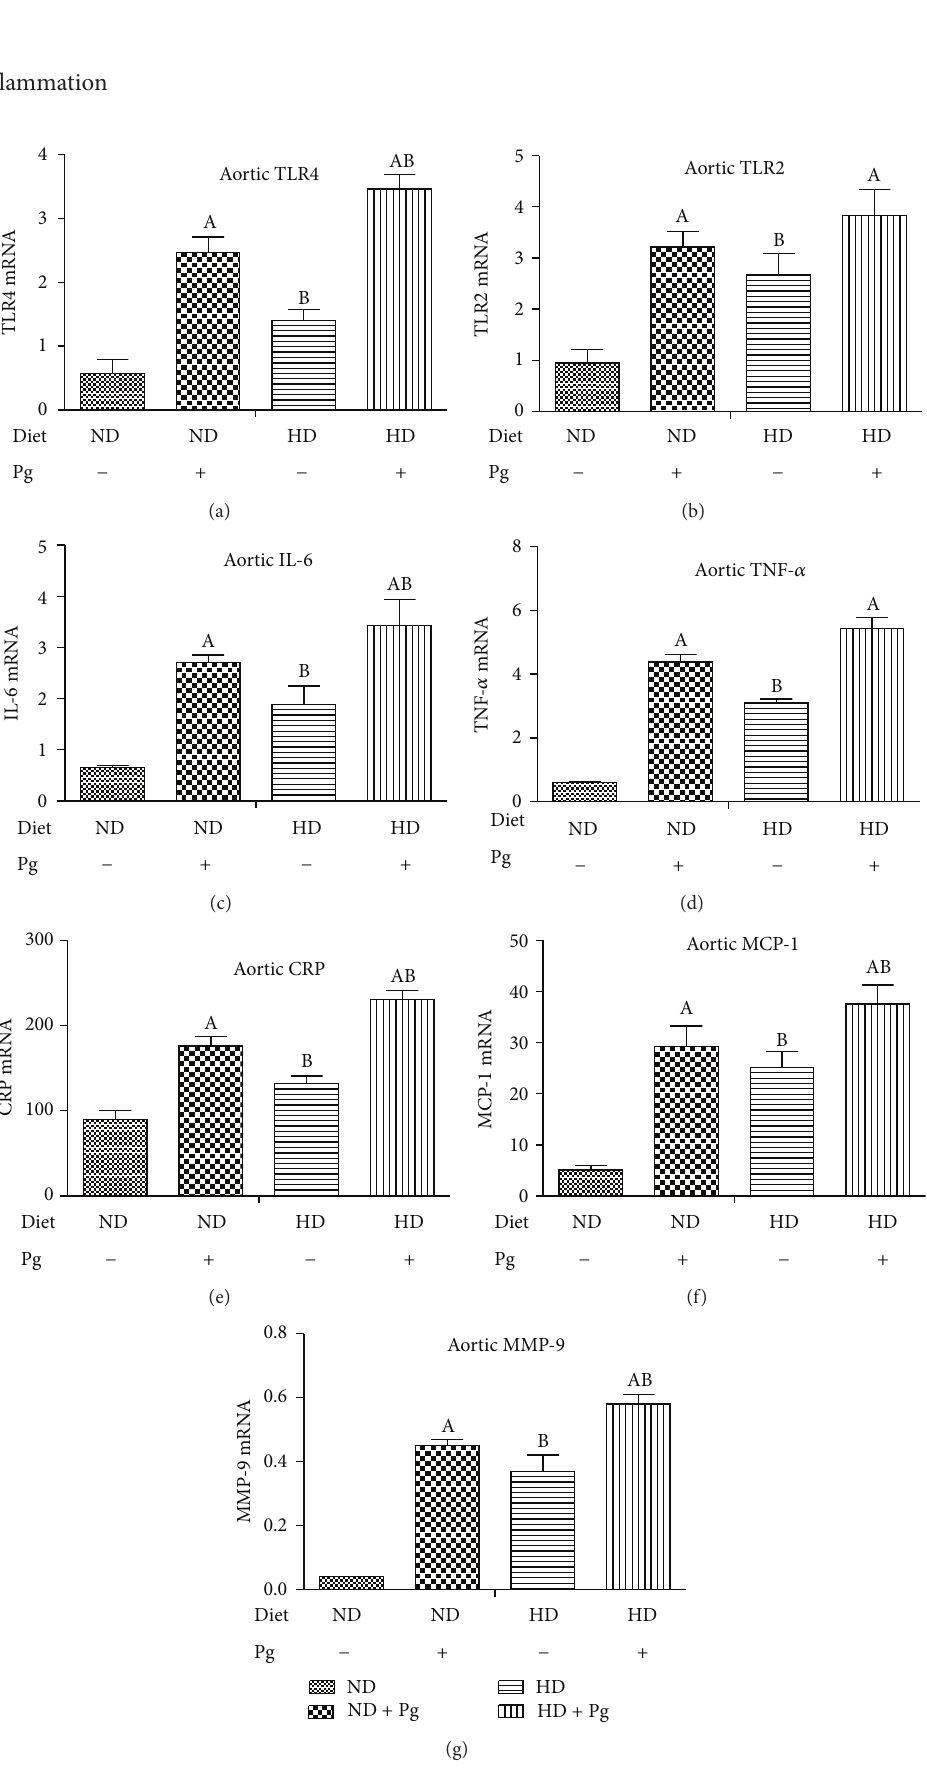
Figure 4: Local aortic expressions of inflammatory factors. A: difference before and after Pg stimulation, 𝑃 < 0.05 ; B: difference before and after high-fat diet, 𝑃 < 0.05 . ND: normal diet; HD: high-fat